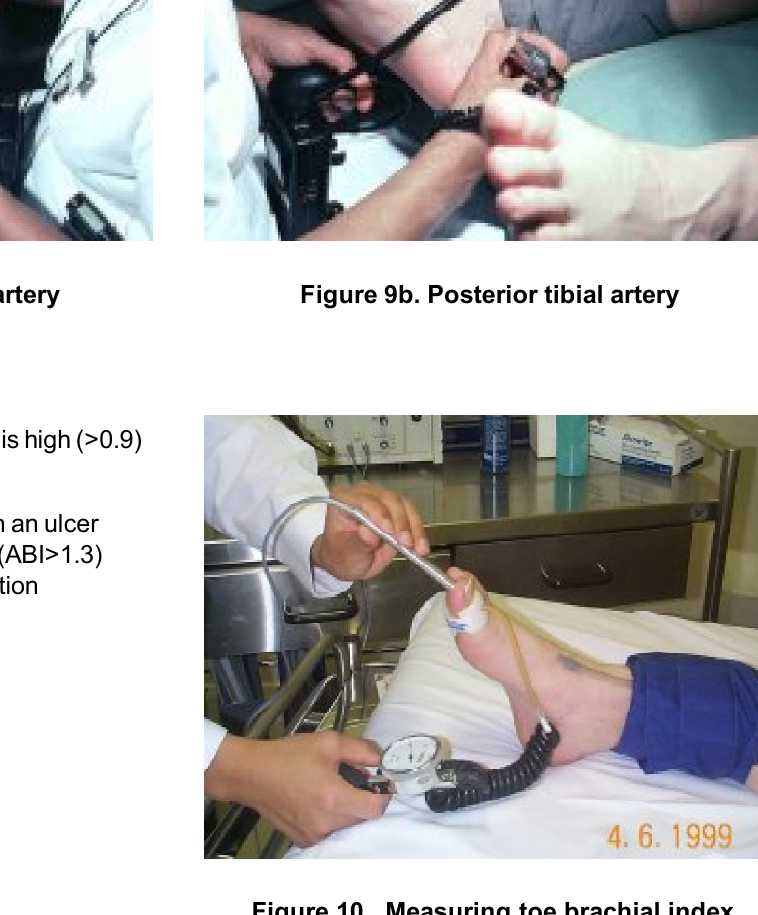
Figure 10. Measuring toe brachial index